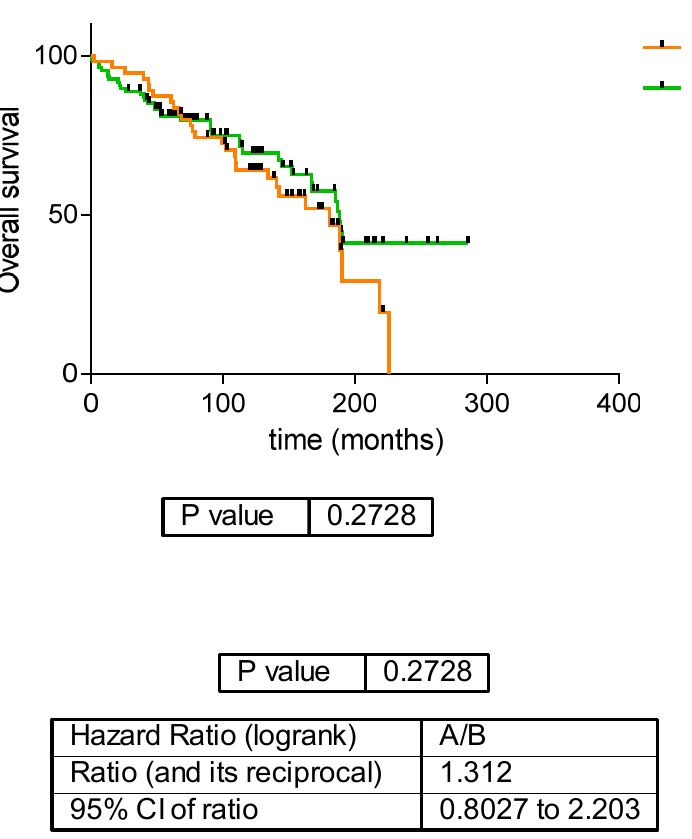
Figure 3. Overall survival in the two ccRCC proteomics subtypes.